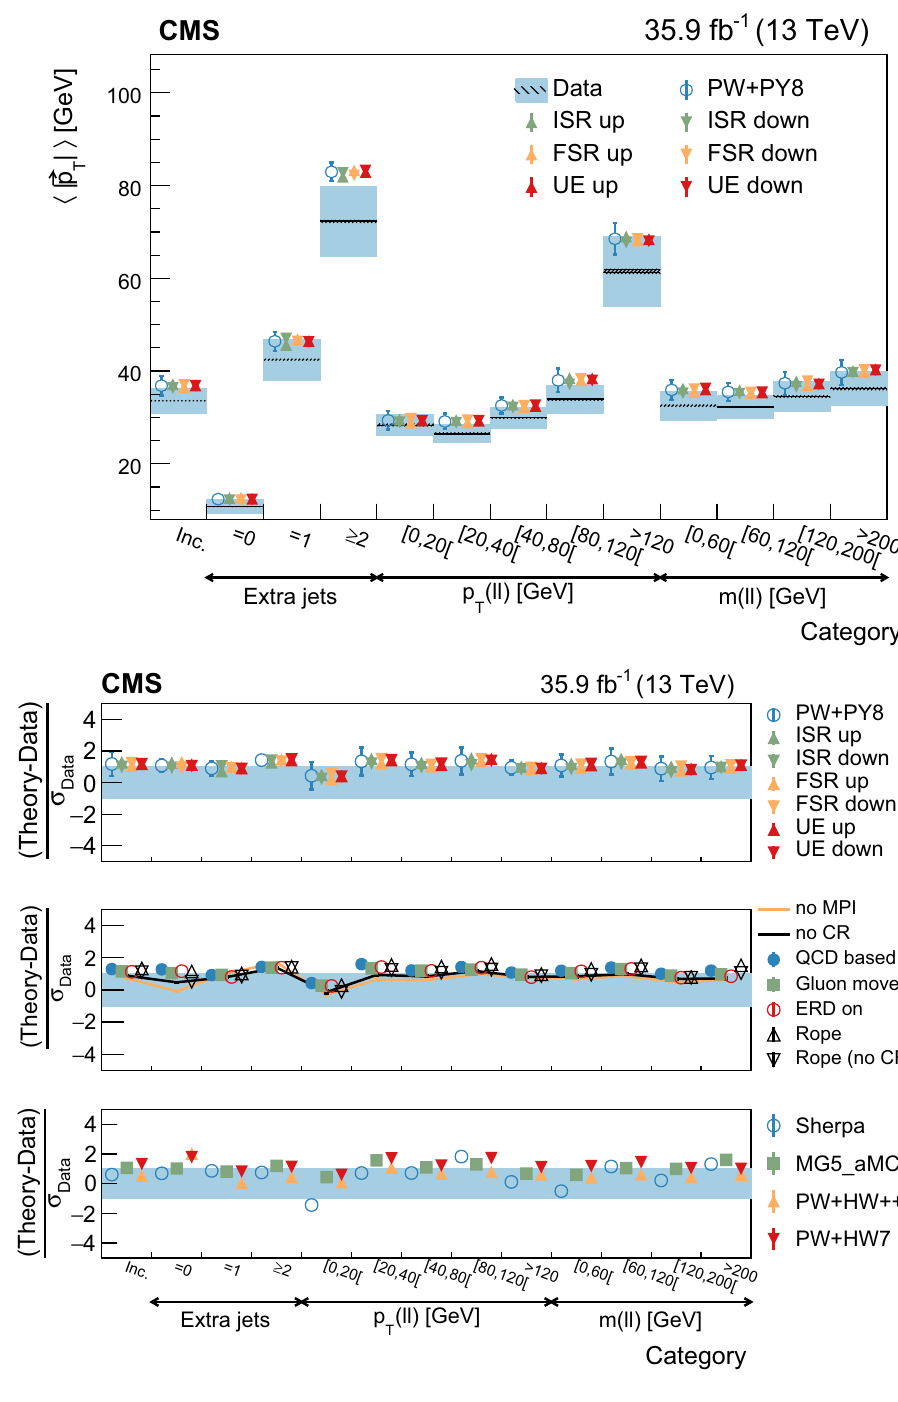
Fig. 19 Average | (cid:7) p T | in different categories. The conventions of Fig. 14 are